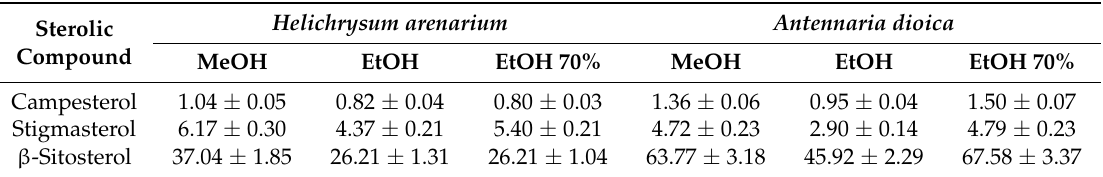
Table 4. The sterolic compounds identified in the flowers of H. arenarium and A. dioica extracts (mg/100 g d.w.).